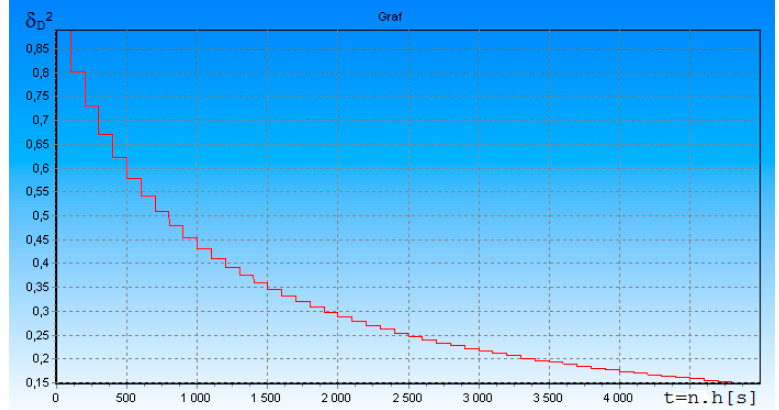
Figure 3. Dependence of the δ D2 of standardized measurement error of the slant range D(t) between FO (Flying Object) and distance-measuring equipment (DME) in the transition process. Time t = 0 to 0.05 s.